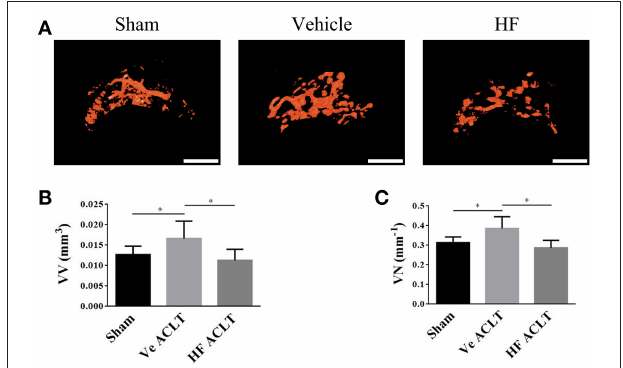
FIGURE 5 | HF maintained the angiogenesis in subchondral bone. 3D µ CT based microangiography of subchondral bone in medial tibial compartment (A) and quantitative analysis of vessel volume (B) and vessel number (C) in subchondral bone at 30 d after sham surgery or ACLT. Scale bar, 500 µ m. * p < 0.05 as denoted by